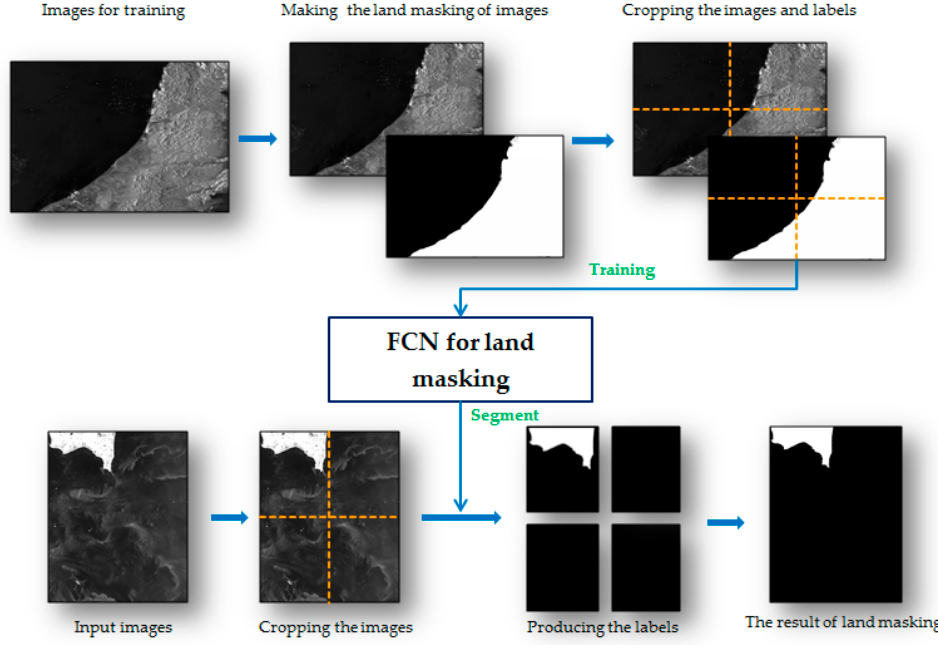
Figure 3. The process of land masking with FCN.